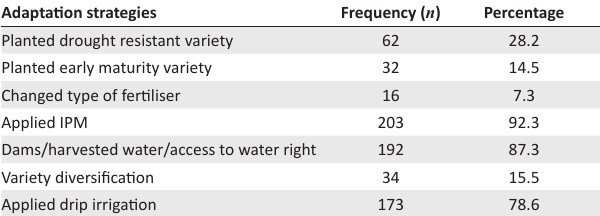
TABLE 2: Climate change adaptation strategies adopted by citrus farmers.